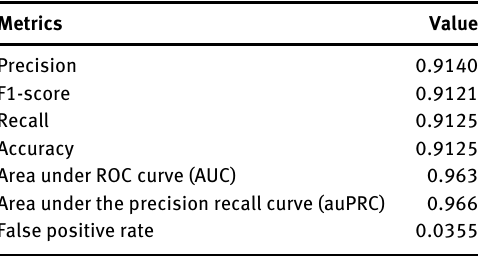
Table 2: Results for each metrics.